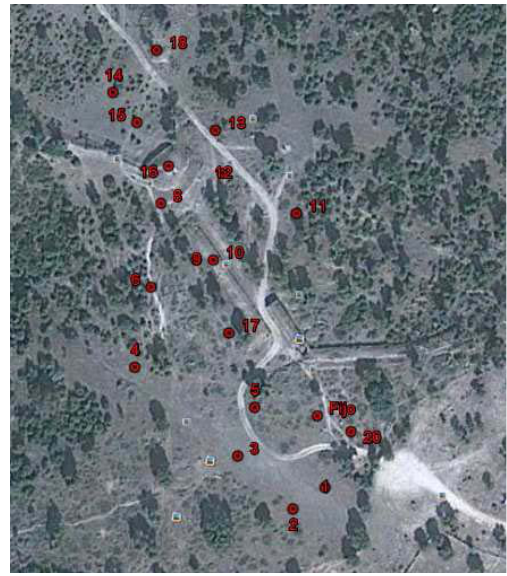
Figure 3. Distribution of ground control points.